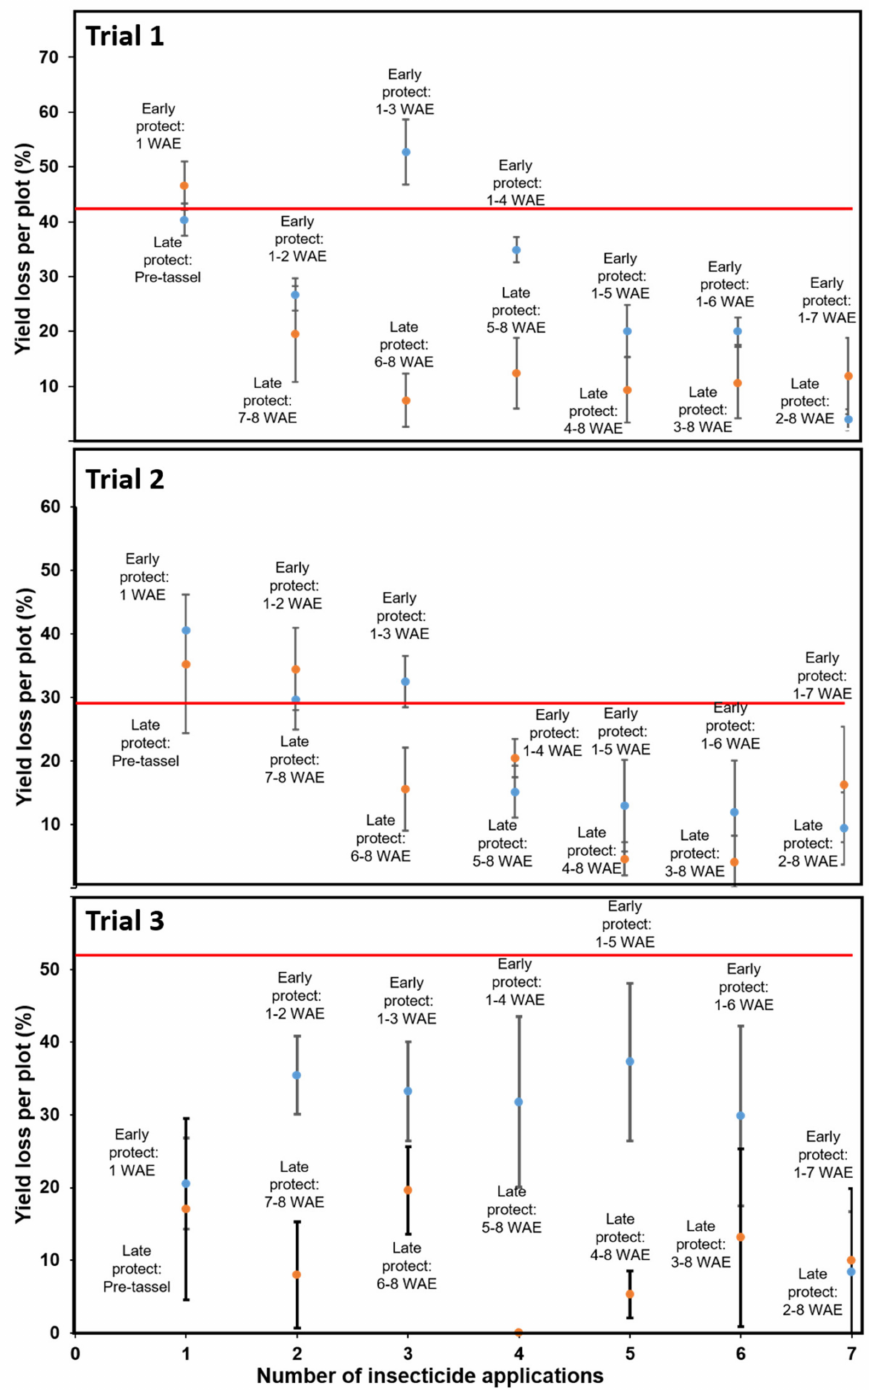
Figure 2. Mean yield loss (%) per plot as a function of the number of insecticide sprays and duration of protection period during the vegetative stages up to the pre-tassel stage of maize. Insecticide applications were completed at various growth stages under high natural Spodoptera frugiperda infestation levels. The first application was completed 1 week after seedling emergence. The red line indicates the mean yield loss of unprotected plots. (Sequence I = blue, Sequence II = orange; bars = standard